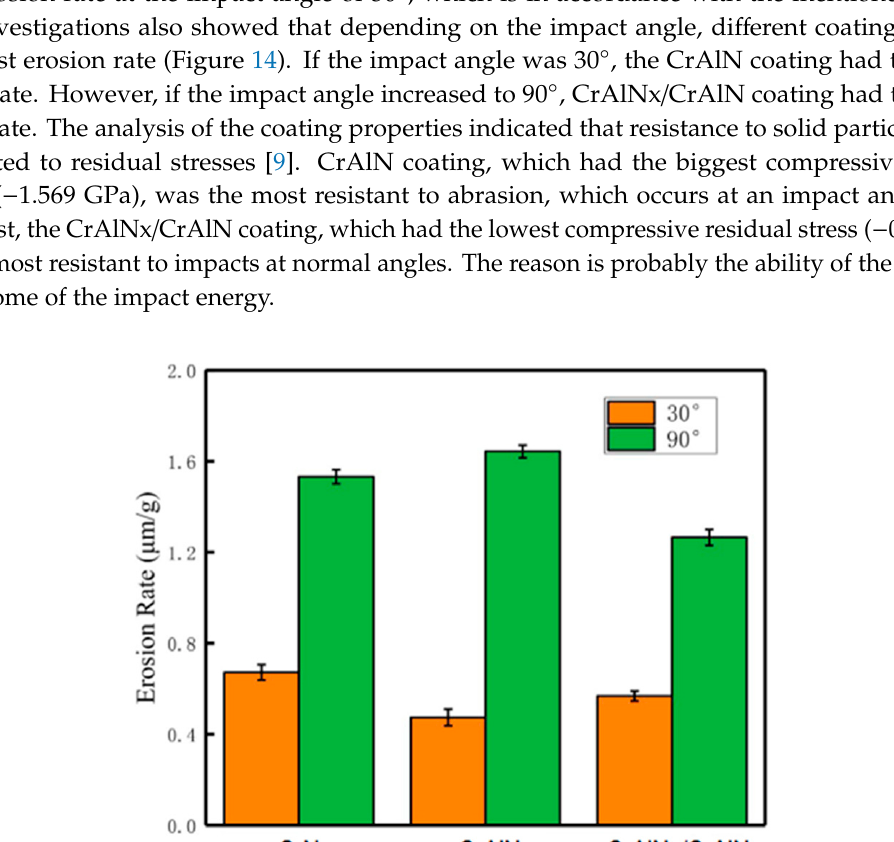
Figure 14. Erosion rate of 2.24 µ m thick CrN, 1.92 µ m thick CrAlN and 2.17 µ m thick CrAlNx / CrAlN coatings deposited on TC11 titanium alloy using the arc ion plating technique, reprinted from Vacuum , Reference [9], with permission from Elsevier.